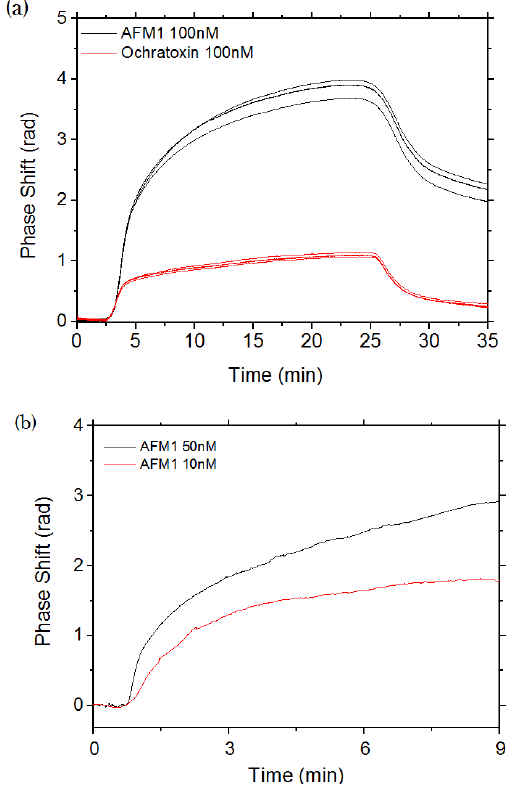
Figure 4. ( a ) Sensorgram recorded on aMZI sensors by flowing AFM1 (black) and Ochratoxin (red) through the microfluidic chamber. At t = 0, MES buffer is flowing through the sensors. The toxin was then injected at t = 2.5 min and at t = 25 min. The toxin flow is stopped and the MES buffer was injected again; ( b ) Sensorgram recorded on one aMZI sensor by flowing a 50 nM (black) and 10 nM (red) AFM1 solutions in the microfluidic chamber. The phase shift is proportional to the Aflatoxin M1 concentration. The actual phase shift is different from the one in (a) since a different sensor was used.